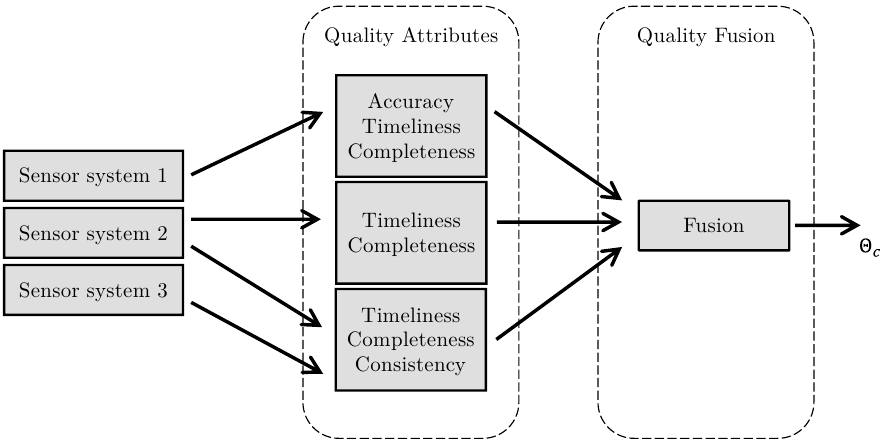
Figure 2. Data quality fusion architecture. Based on data from sensor systems, data quality attributes are calculated. Some attributes require input from multiple sensors. The attributes are passed into the fusion algorithm which outputs θ c , the combined data quality